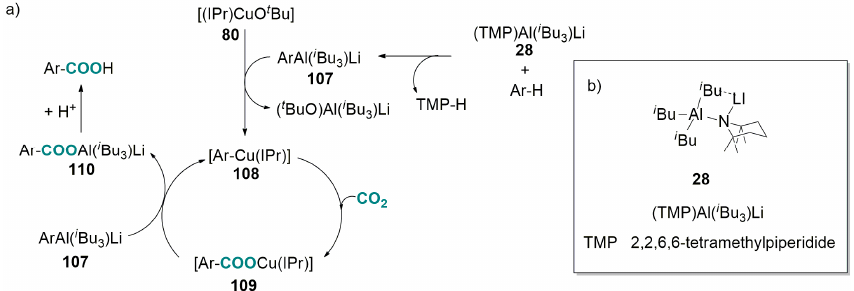
Scheme 44. Selected examples for carboxylation reactions of aromatic compounds bearing a directing group and heteroarenes by ( i Bu) 3 Al(TMP)Li base in conjunction with [(IPr)CuO t Bu] complex catalysis.